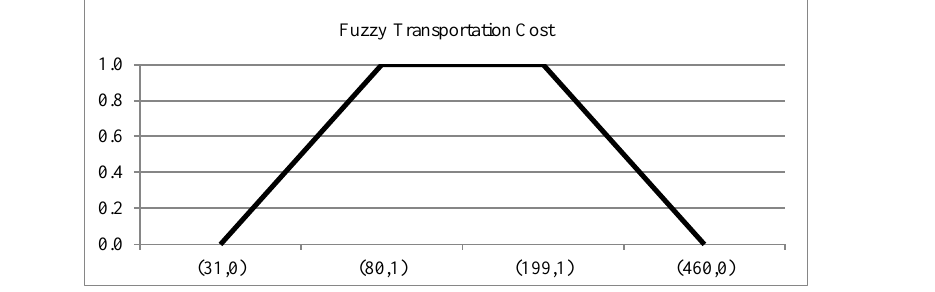
Figure 1. Optimal Fuzzy Transportation